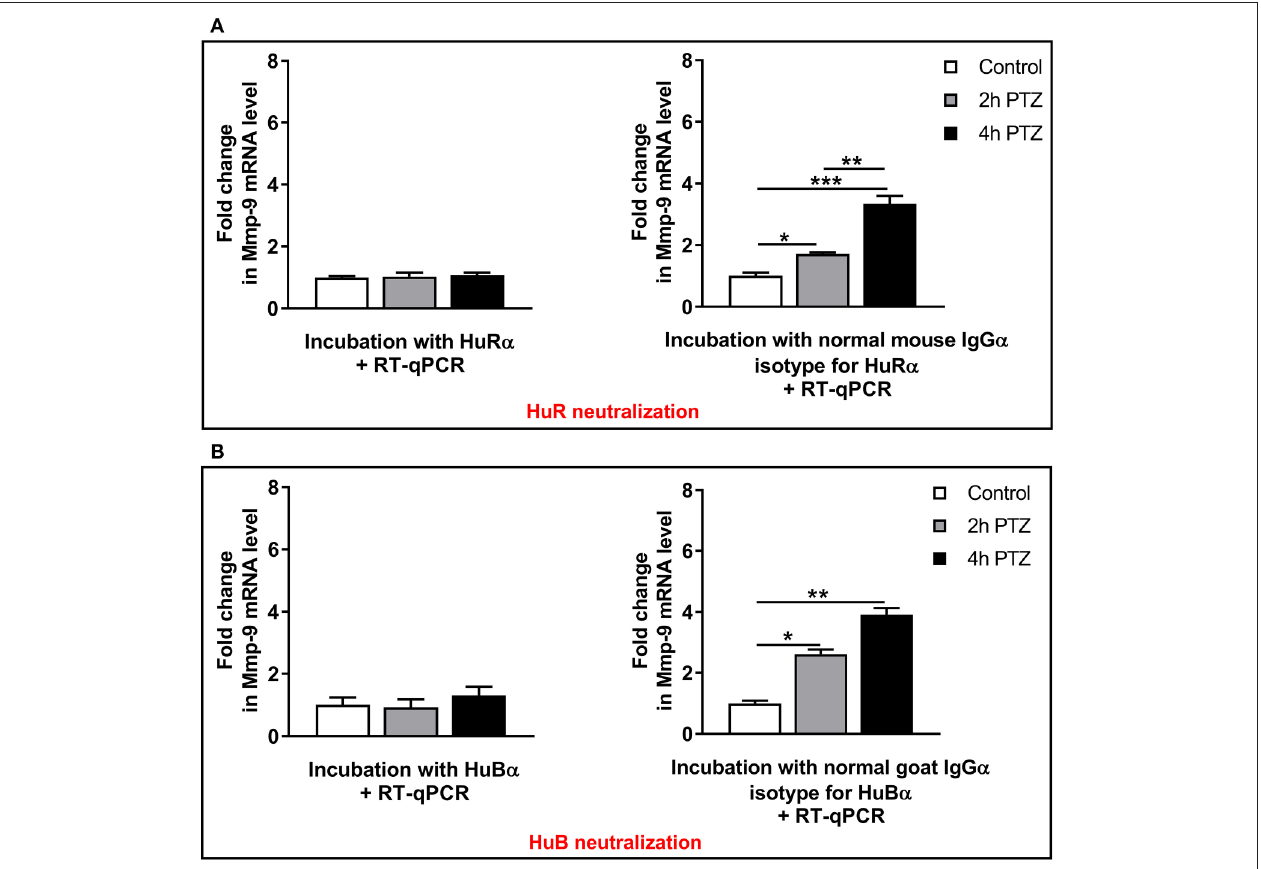
FIGURE 7 | HuR or HuB depletion by immunoneutralization completely blocks the occurrence of PTZ-induced Mmp-9 mRNA stabilization in the rat hippocampus. Hippocampal cytoplasmic protein lysates (130 µ g) derived from unstimulated (control) or PTZ-treated (2 and 4h after the onset of seizures) rat hippocampi were pretreated with 0.4 µ g of anti-HuR or normal mouse isotype antibody (A) , or anti-HuB or normal goat isotype antibody (B) , and then incubated with 20 µ g of total RNA obtained from PTZ-treated rat hippocampi. The incubation was stopped after 60min and the extracted RNA was evaluated for Mmp-9 mRNA expression by qRT-PCR. Data are presented as fold change in mRNA expression. One-way ANOVA was followed by Tukey’s multiple comparisons test. Values are mean ± SEM (* p < 0.05; ** p < 0.01; *** p < 0.001; n =